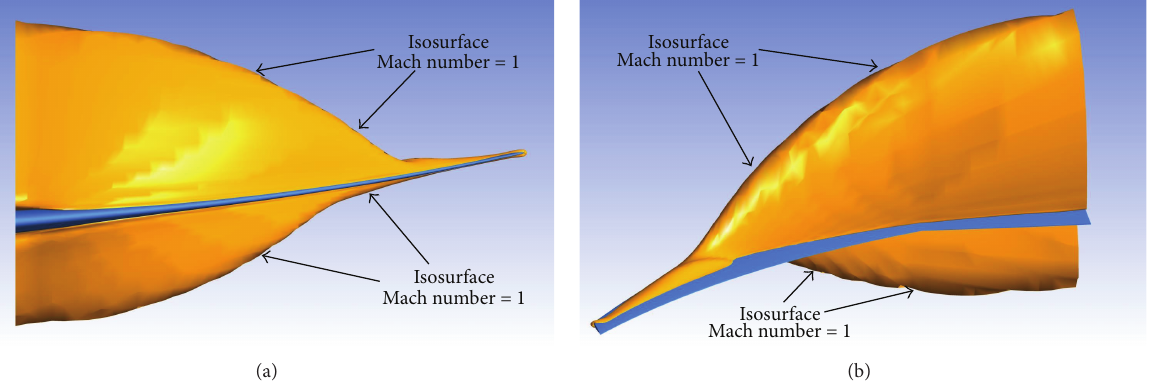
Figure 11: (a) Front view of the supersonic zone around the curved wing (Case 2 , Mach = 0.90, time = 6.5 s). (b) Rear view of the supersonic zone around the curved wing (Case 2 , Mach = 0.90, time = 6.5 s).